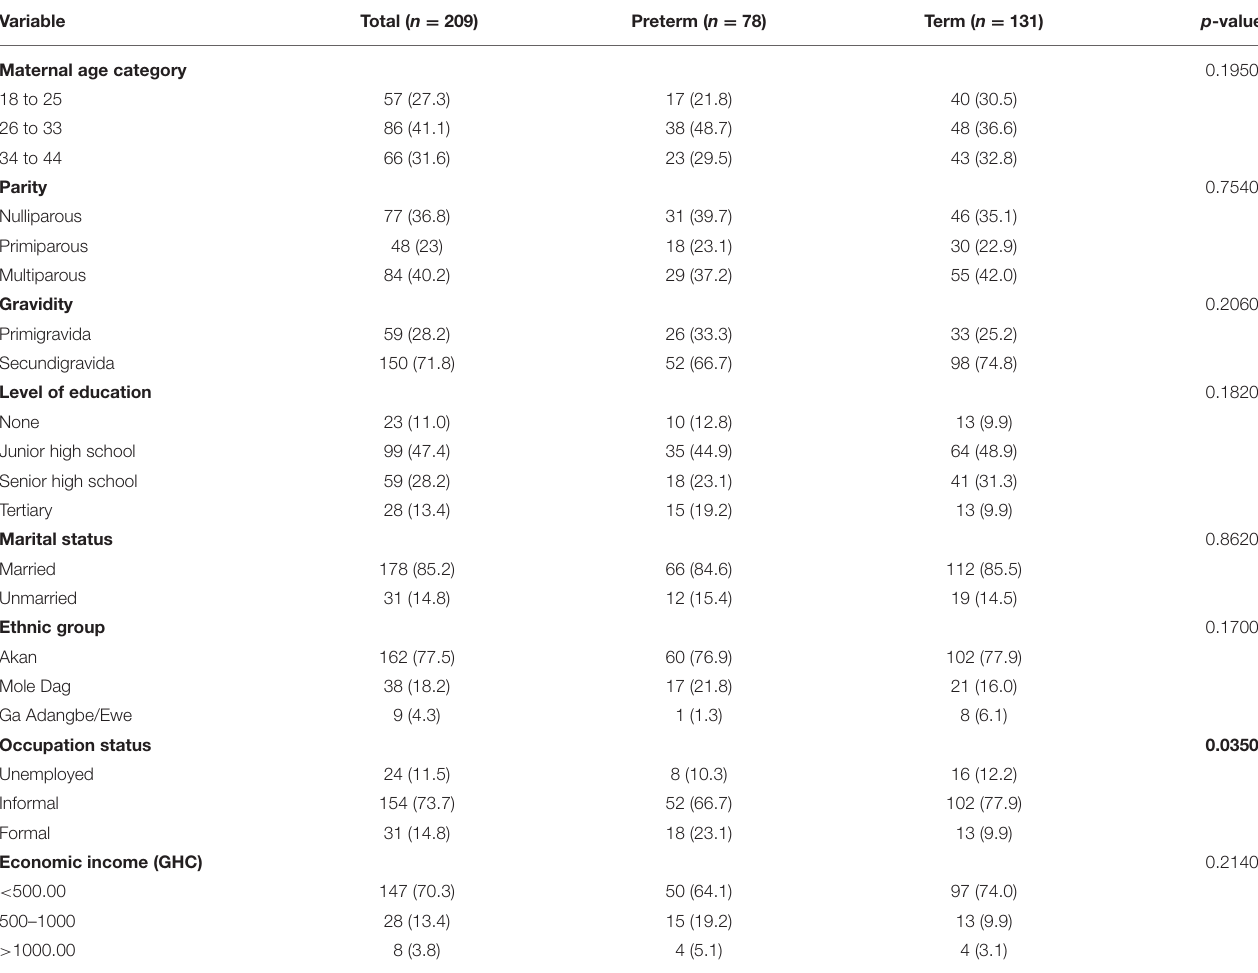
TABLE 1 | Association of pretermbirth with sociodemographic and obstetric factors among pregnant women.